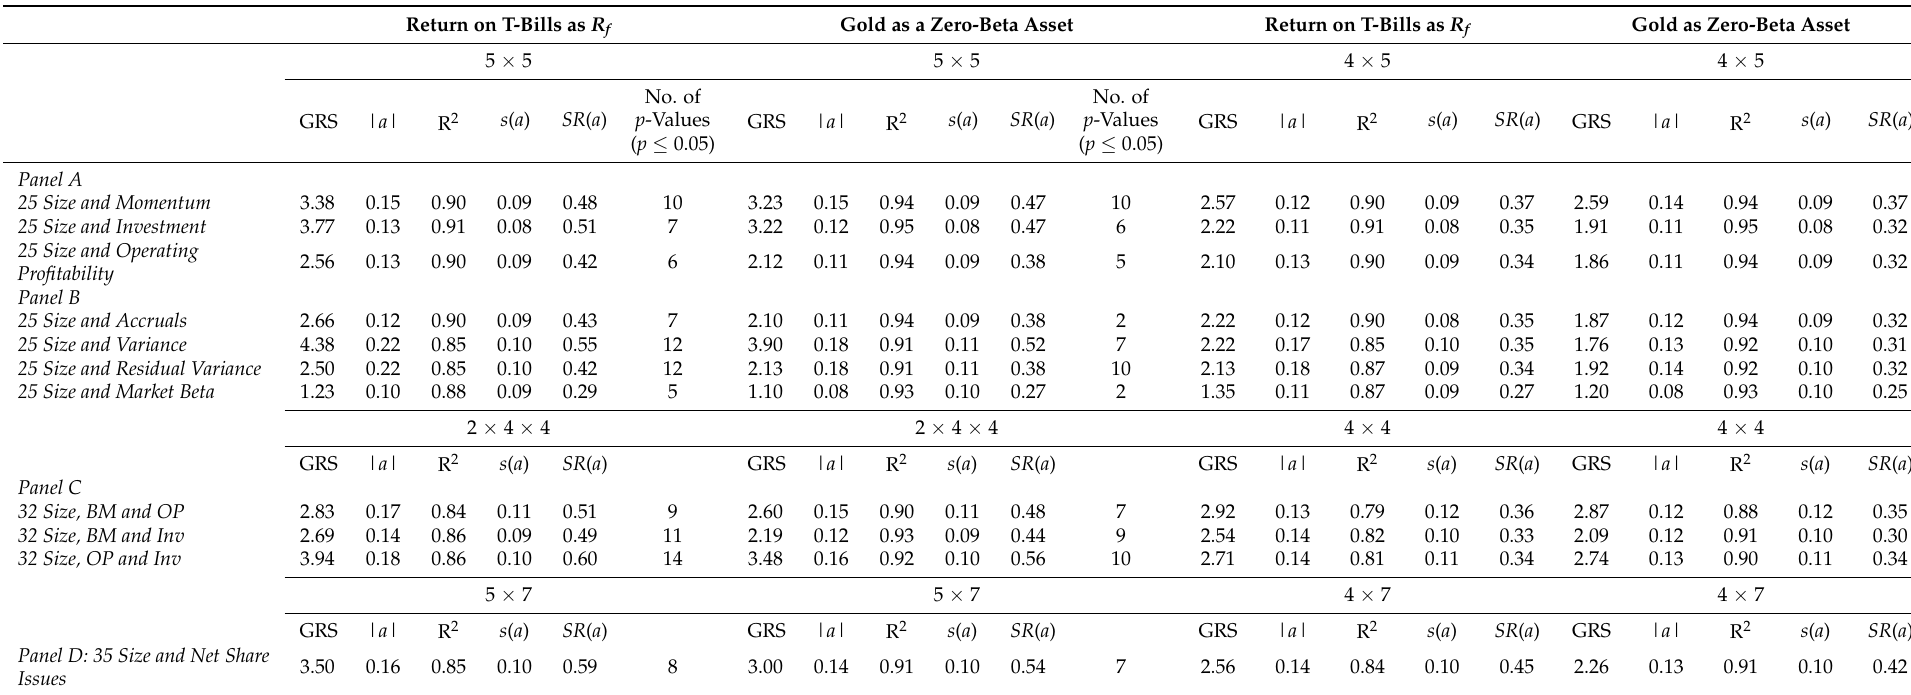
Table 11. Statistical summary of the GRS test to explain four-factor and G-four-factor regressions from January 1981 to December 2015. The GRS statistic tests the null hypothesis that the alphas of all portfolios are jointly equal to zero. | a | is the average absolute alpha; R 2 is the mean-adjusted R-squared; s ( a ) is the mean standard error of alphas; and SR ( a ) is the average Sharpe ratio of alphas. The critical values for GRS statistic are 90%: 1.41; 95%: 1.56; 97.5%: 1.69; 99%: 1.86, and 99.9%: 2.25. Panel A shows results on 25 size and momentum, 25 size and investment, and 25 size and operating profitability portfolios. Panel B shows results on 25 size and accruals, 25 size and variance, 25 size and residual variance, and 25 size and market beta portfolios with (5 × 5) and without microcaps (4 × 5). Panel C shows results on 32 size, book-to-market, and operating profitability; 32 size, book-to-market, and investment; and 32 size, operating profitability, and investment portfolios with (5 × 5) and without microcaps (4 × 5). Panel D shows results on 35 size and net share issues portfolios with (5 × 5) and without microcaps (4 × 5). Return on T-Bills as R f Gold as a Zero-Beta